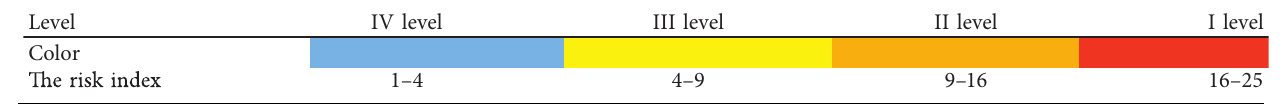
Table 10: Standard color identification of risk levels.